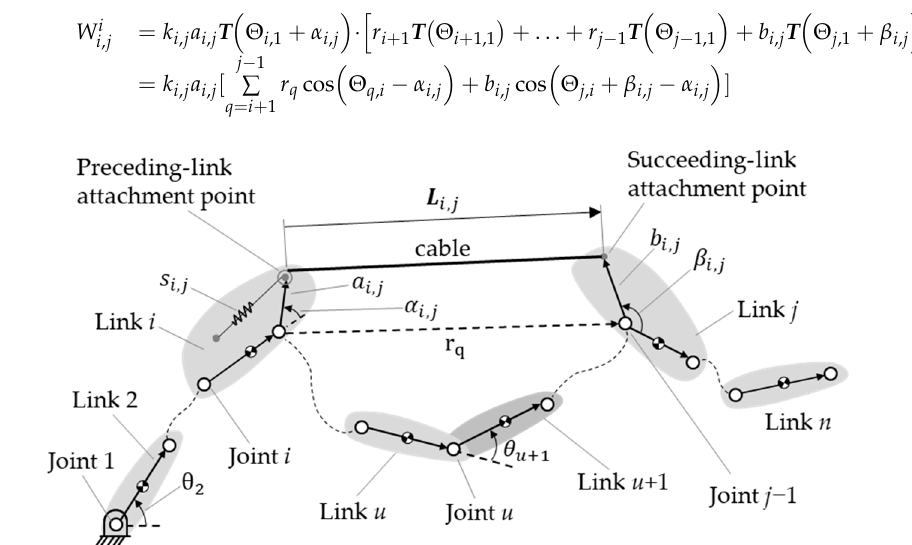
Figure 3. A typical spring 𝑠 (cid:3036),(cid:3037) in an n -link manipulator.